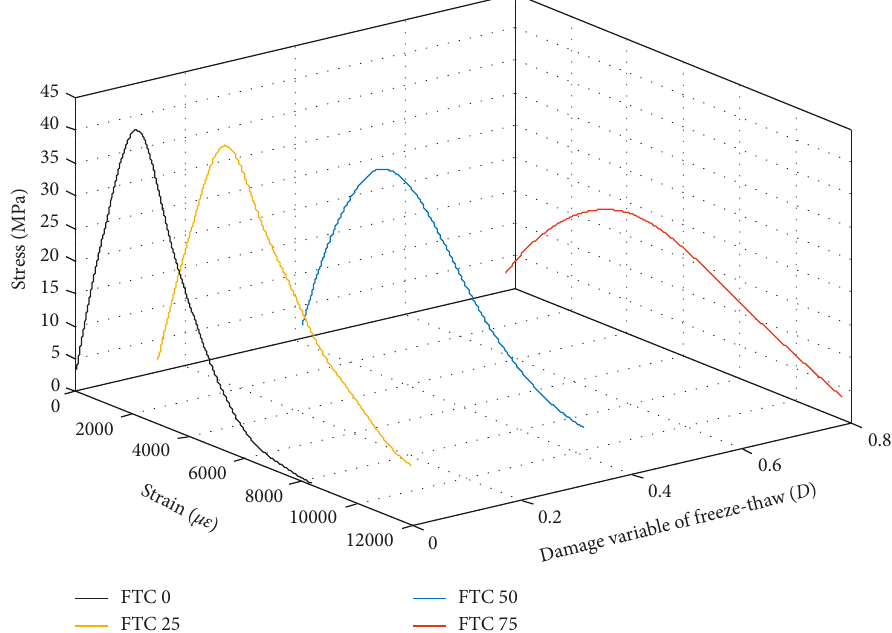
Figure 4: Uniaxial compression stress-strain curves in a three-dimensional coordinate system.